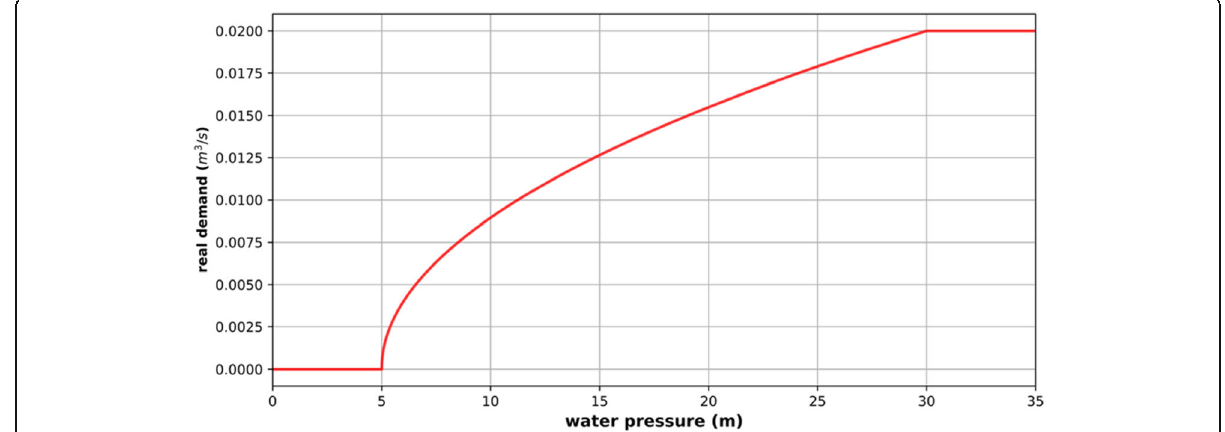
Fig. 4 Example of the relationship between water demand and pressure head at a node with base demand of 0.02 m 3 /